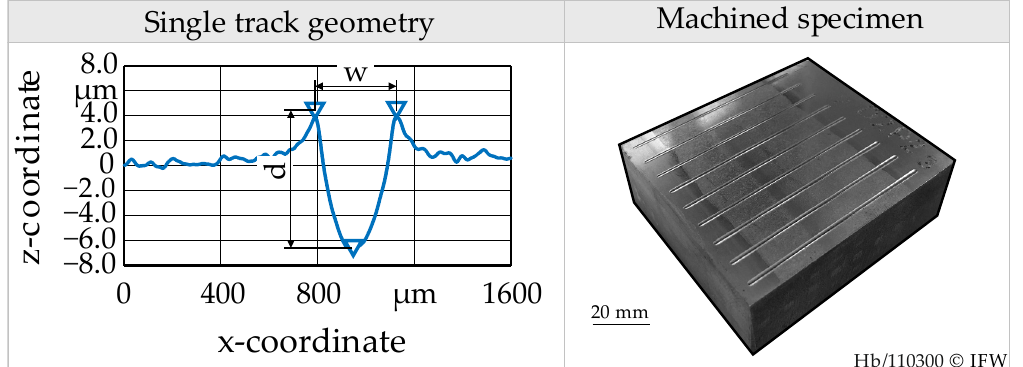
Figure 4. Single-track geometry and machined specimen .